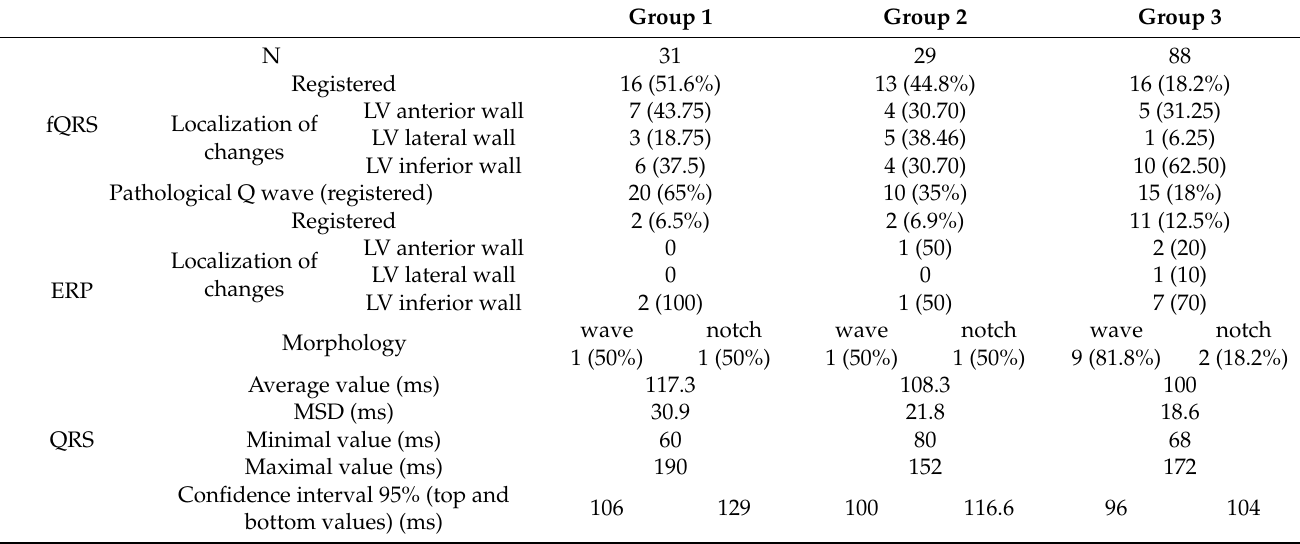
Table 7. Summary for three EF